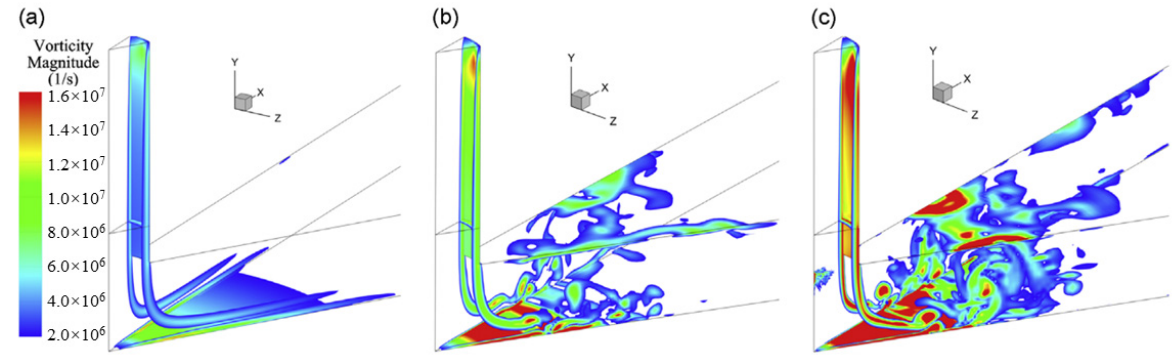
Figure 14. ( a – c ) Contours of instantaneous vorticity under different supply pressure. Re ‐ printed/adapted with permission from Ref. [95]. 2022, Qi Zhao.